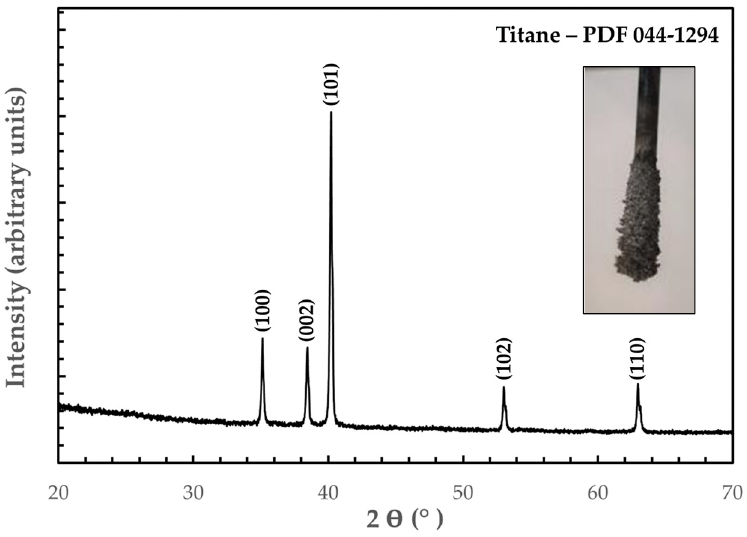
Figure 4. X-ray diffraction of titanium metal deposited on the cathode under the current density of 60 mA·cm − 2 in LiCl-LiF-TiF 3 (0.62 mol/kg) at 853 K (580 °C). Insert image of titanium deposit.